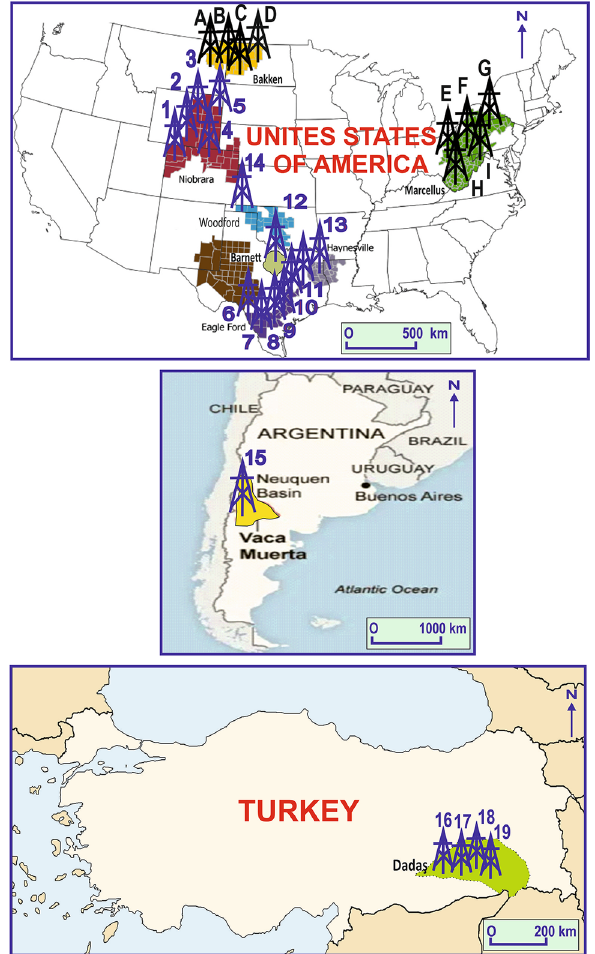
Figure 1. Location map of the wells of the training and validation dataset (1–19) and the S1 volumes prediction dataset (A–I). 1–5 = Niobrara Shale, 6–11 = Eagle Ford Shale, 12 = Barnett Shale, 13 =